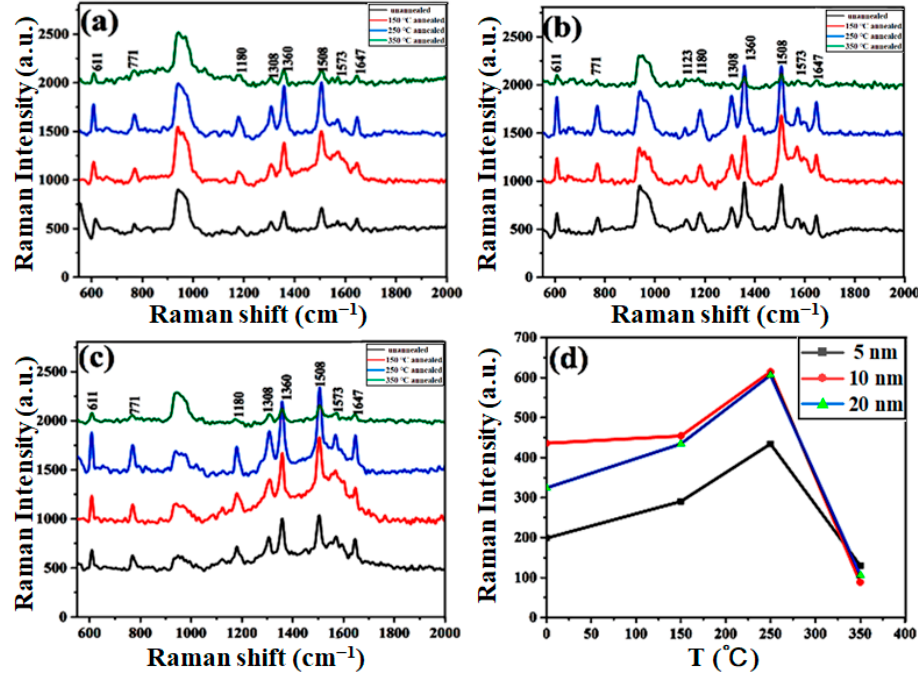
Figure 5. Raman spectra of 10 − 7 M R6G on Au films with various film thicknesses under different annealing temperatures: ( a ) 5 nm, ( b ) 10 nm and ( c ) 20 nm. ( d ) Relationship between the intensity of the R6G characteristic peak of 1508 cm − 1 and the annealing temperature of Au films with various film thicknesses.